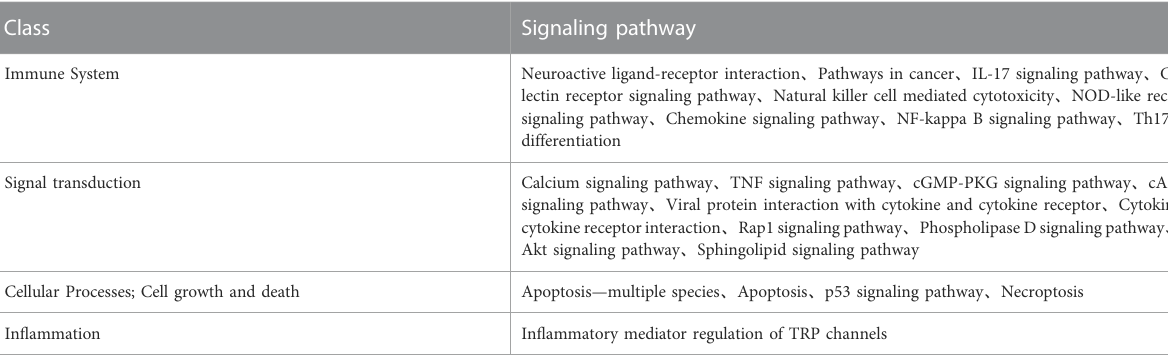
TABLE 2 Breakdown of pathway classi fi cation related to RA treatment by